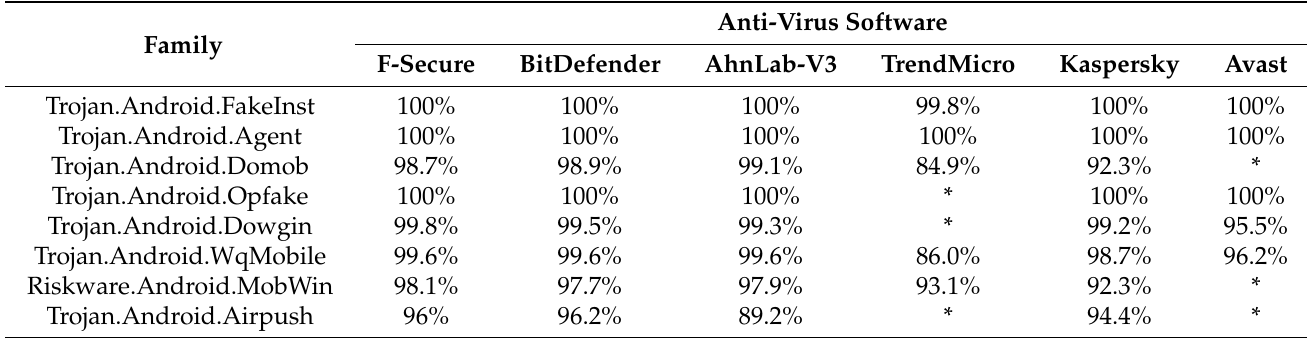
Table 13. Proportion of similar samples extracted that belong to the same family based on similar module detection.